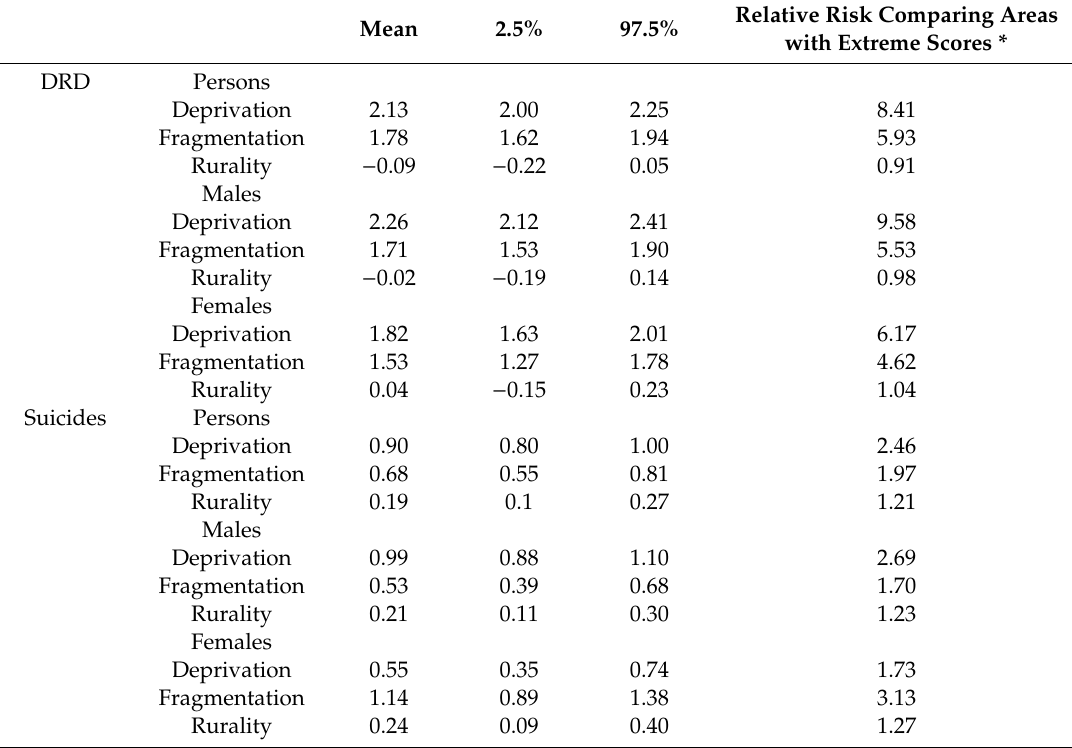
Table 4. Estimated Regression Coe ffi cients (Drug Related Deaths and